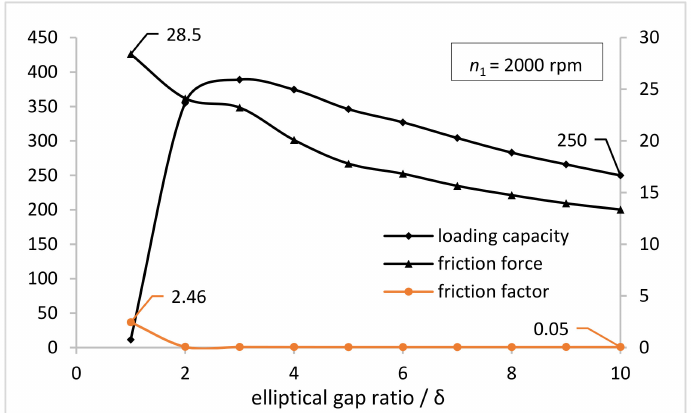
Figure 5. Variations of the loading capacity and friction force and friction factor on the inner wall of the FS with the elliptical gap ratio ( n 1 = 2000 rpm).